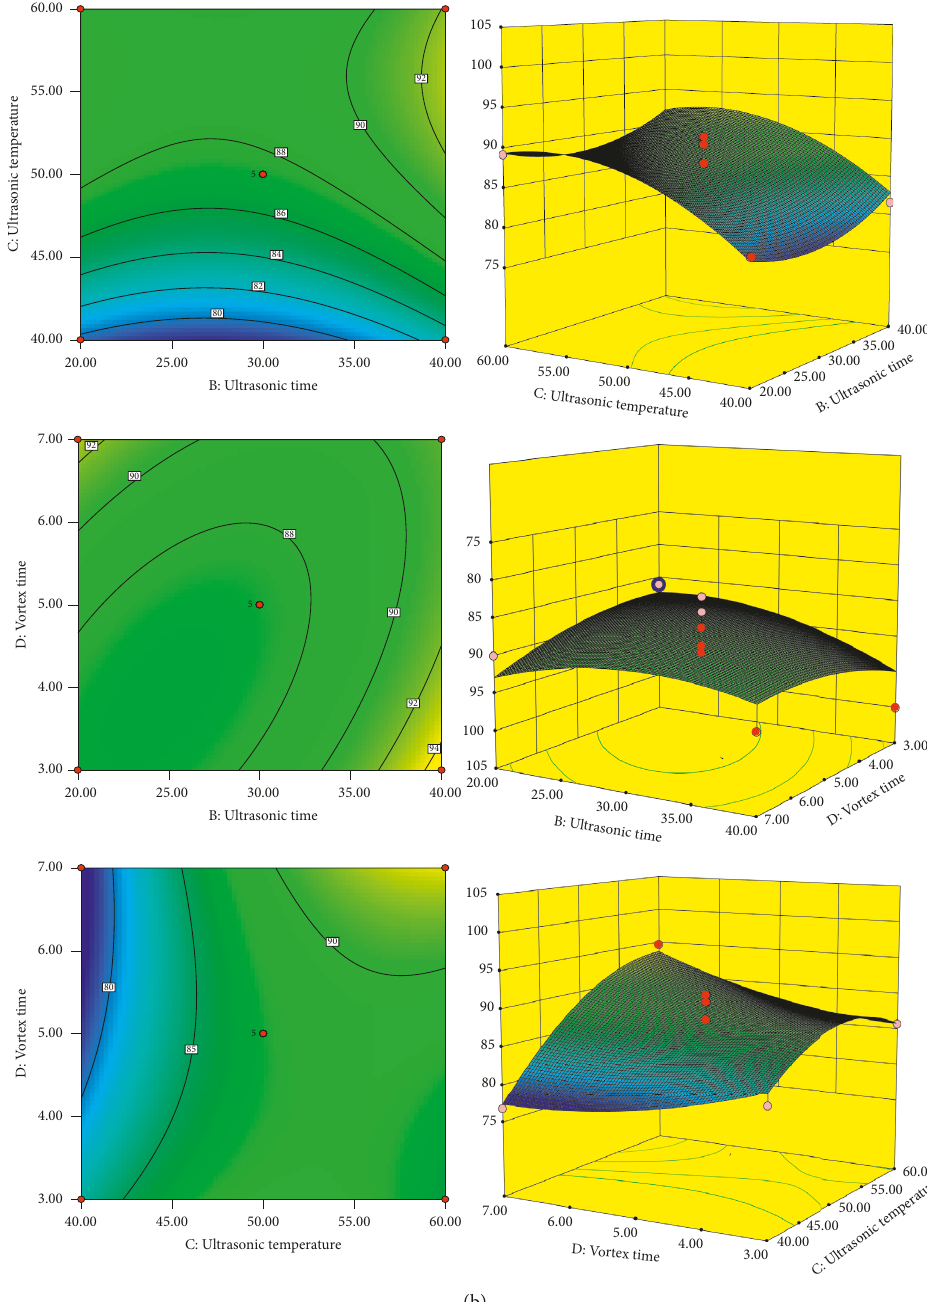
Figure 3: Response surface drawings of PcS analyzed by interaction of two